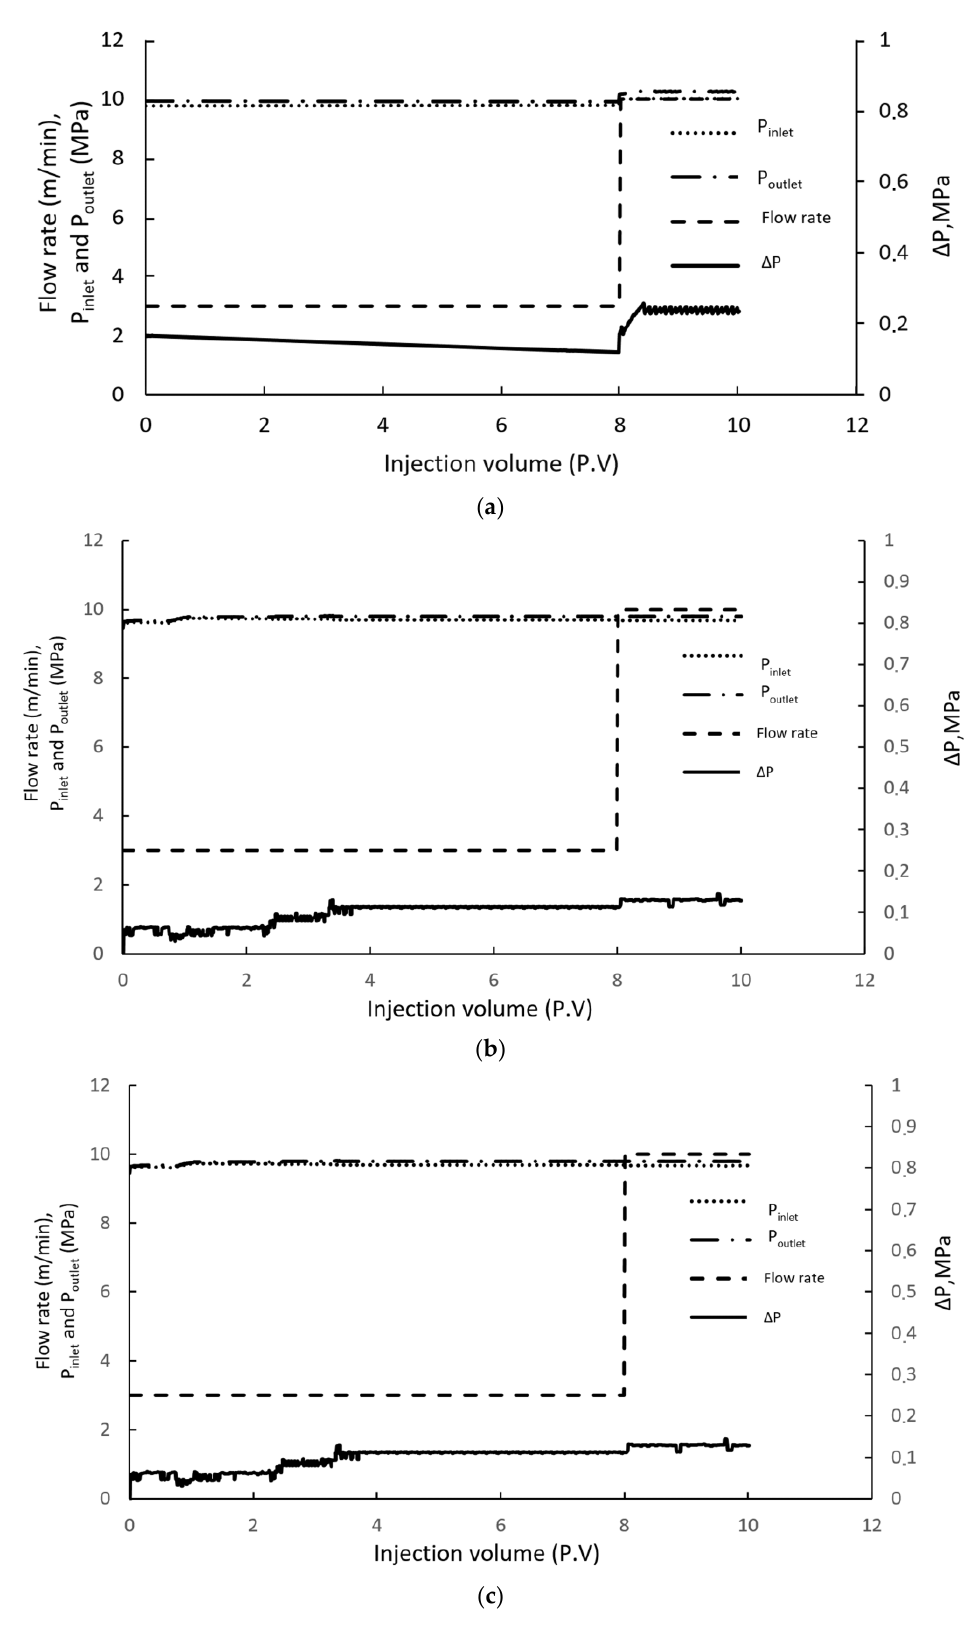
Figure 4. Filtration dynamics in the experiment with formation water ( a ), toluene ( b ) and o-xylene ( c